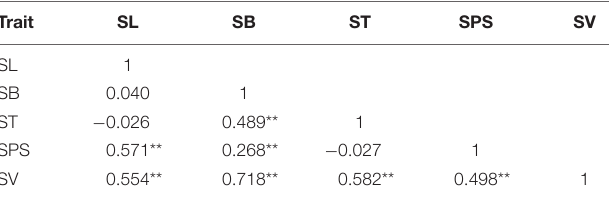
TABLE 2 | Phenotypic correlations among five silique-related traits in the AH population.